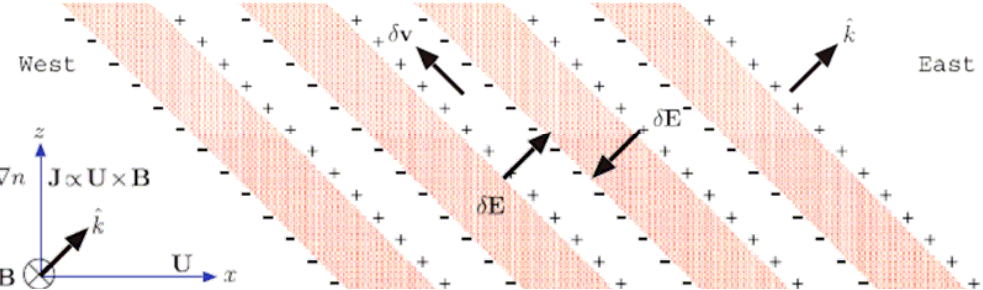
Figure 20. Cartoon showing the physical processes responsible for the "collisional shear instability" which has been proposed to seed a later GRT instability. The mechanism is as follows: The wind, U, produces a vertical current, J, the current polarizes the wave fronts, the polarization field, δ E, produces drifts, δ v, along the fronts, increasing the original amplitude of the wave perturbation, increasing, in turn, its polarization and consequently the amplitude of the wave perturbation. (After Kudeki et al., 2007).